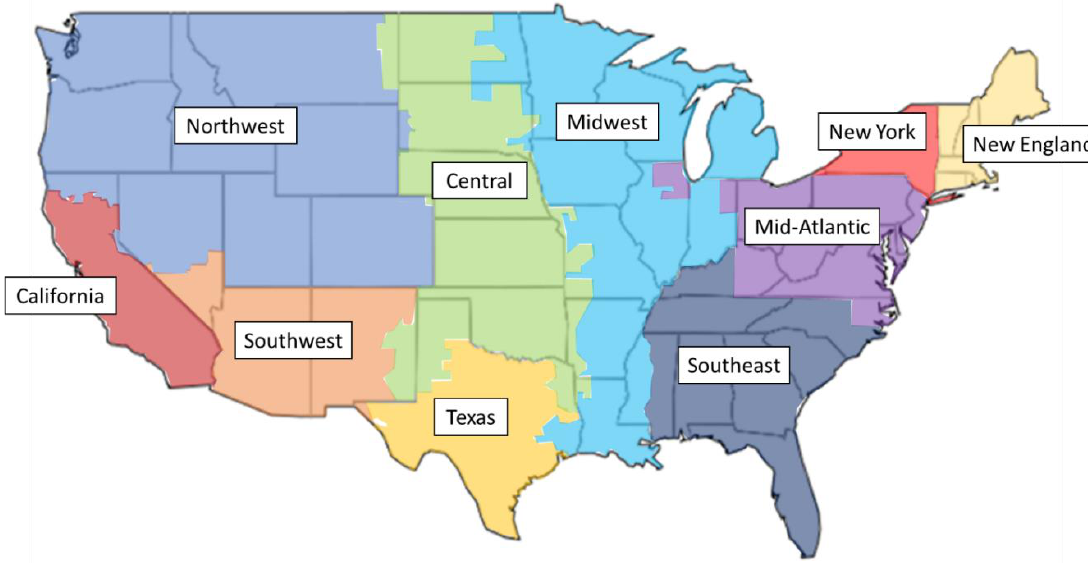
Figure 1. Electricity market regions defined in the model.